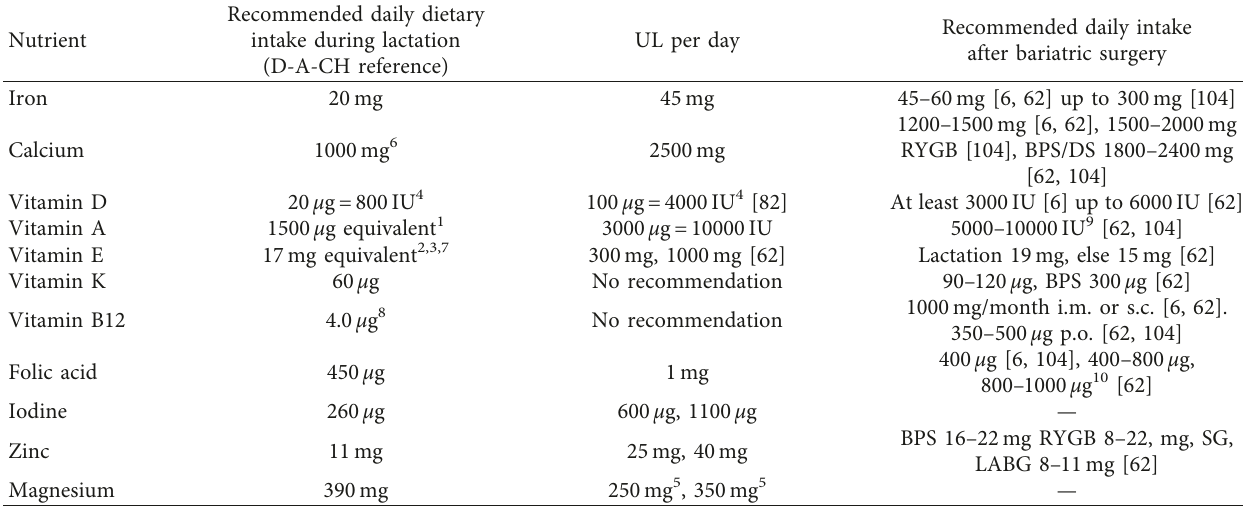
Table 5: D-A-CH recommendations of nutritional intake during lactation [68] and tolerable upper intake level (UL) according to EFSA Guidelines [102] or the NIH [103] for healthy nonbariatric women as well as recommendations for intake after bariatric surgery for women (when available, data specific for lactation are